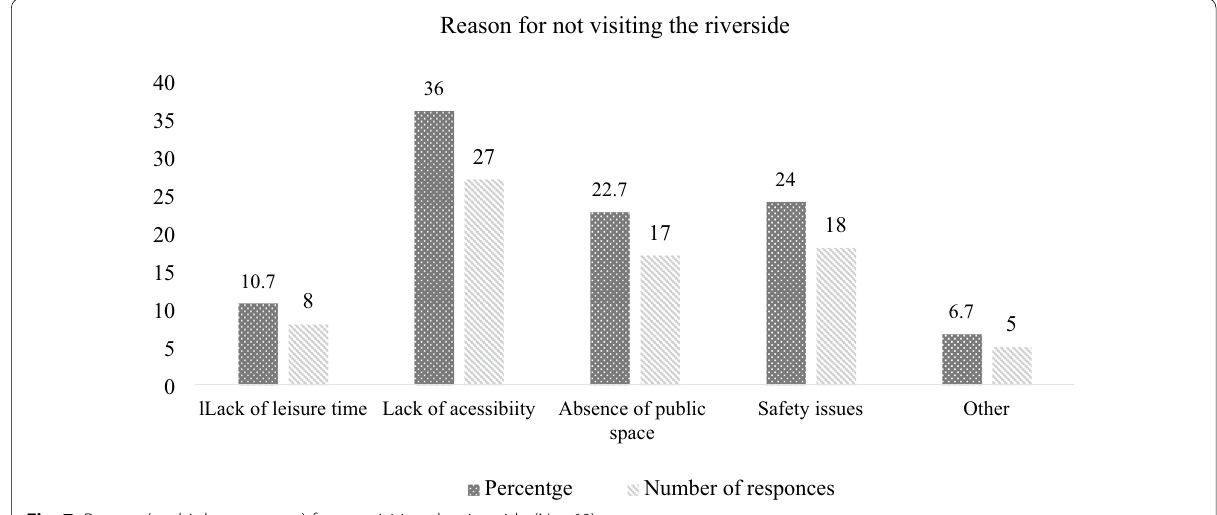
Fig. 7 Reason (multiple responses) for not visiting the riverside (N